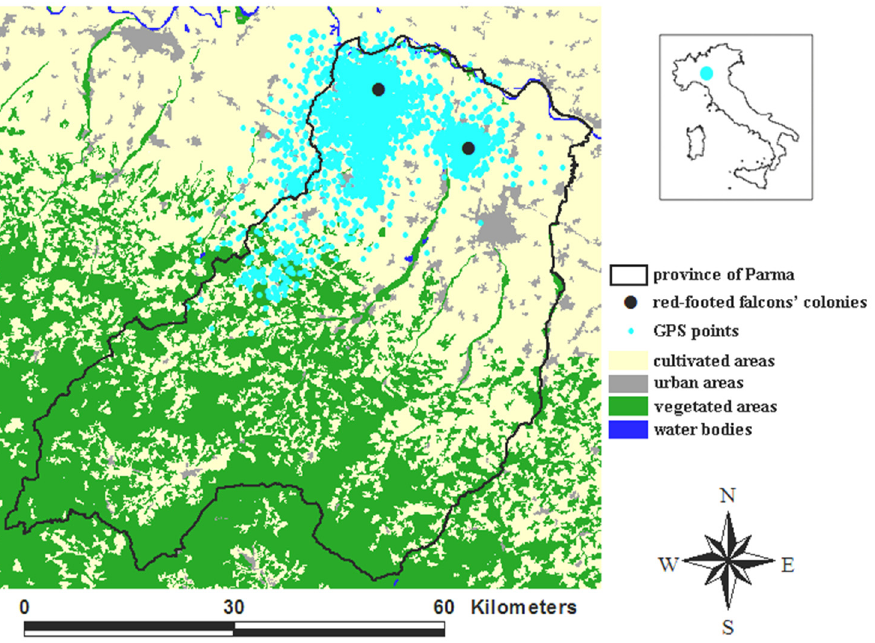
Figure 1. Study area (province of Parma, Italy). A total of 13,484 GPS points (cyan dots) of the 8 red-footed falcons tracked from mid-June to the end of July in 2019, 2020, and 2021 are shown. The two black dots mark the two red-footed falcons’ colonies.